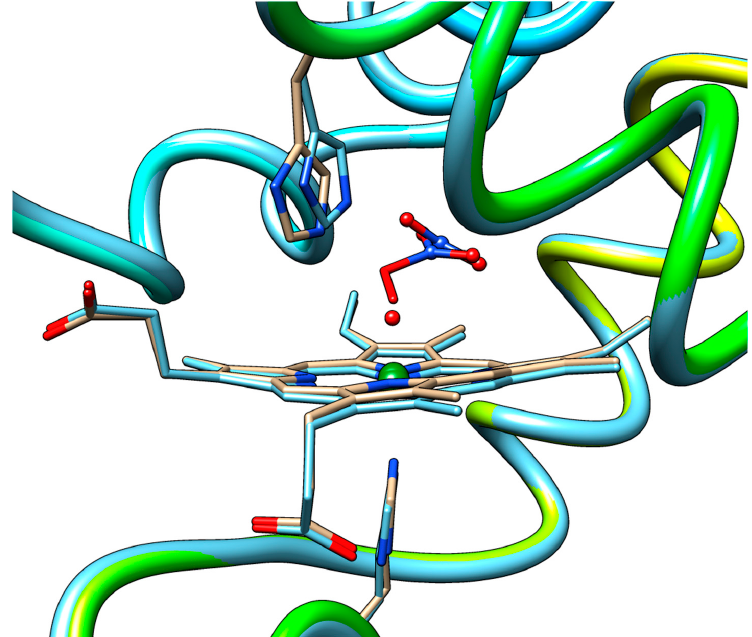
Figure 4. Superimposed QM/MM-optimized geometries of the equilibrium state of the